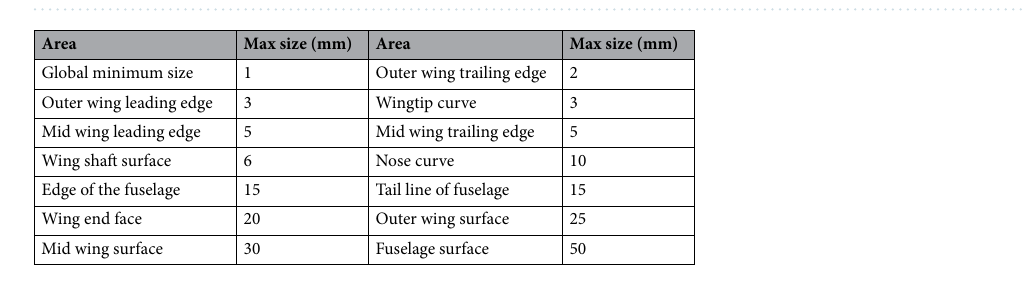
Table 2. The mesh size distribution on the surface of each part of the